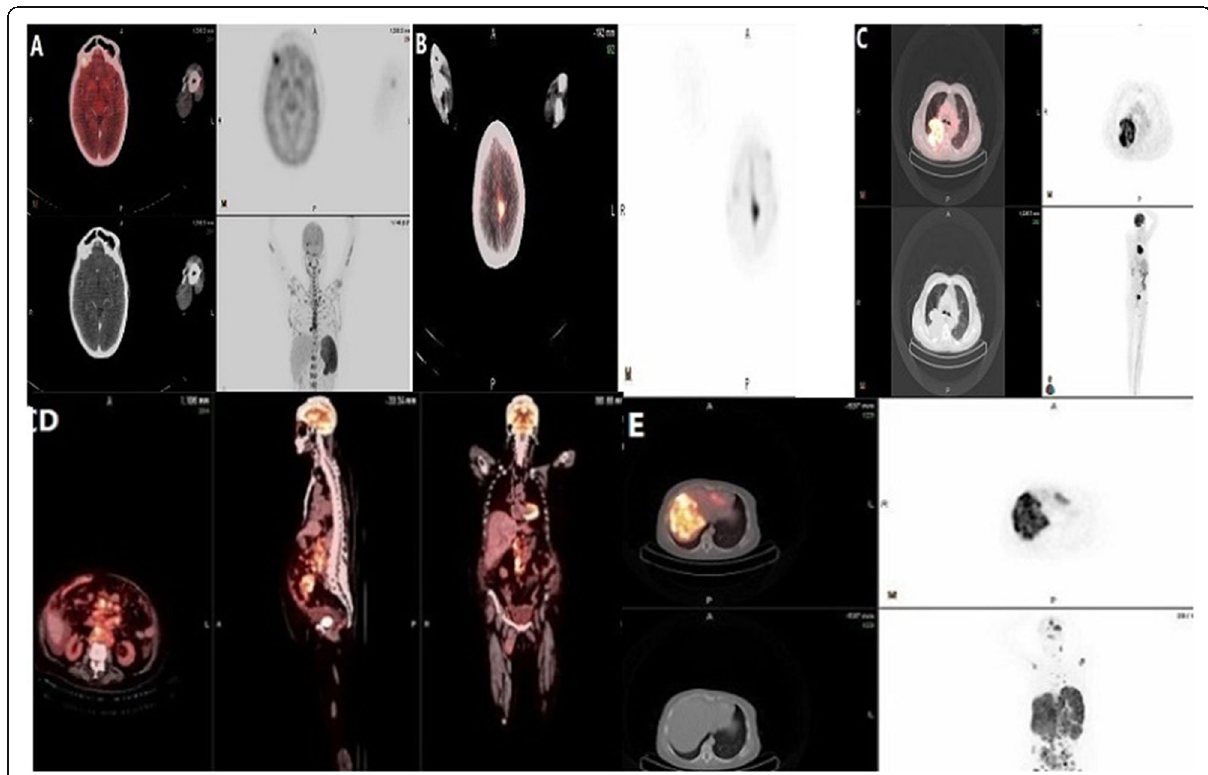
Fig. 4 A 49-year-old male with brain metastasis in the right frontal lobe and left parasagittal region from an unknown primary. a , b Axial fused PET/CT and CT scan showed two active metastatic lesions seen in the right frontal lobe and another one in the left parasagittal region. c Multiplanar fused PET/CT and PET scan showed a large mass in the right lung with active uptake proved by bronchoscopic biopsy to be bronchogenic carcinoma. d Multiplanar fused PET/CT scan showed multiple metastatic para-oartic lymph nodes. e Multiplanar fused PET/CT and PET scan showed multiple metastatic active lesions in the